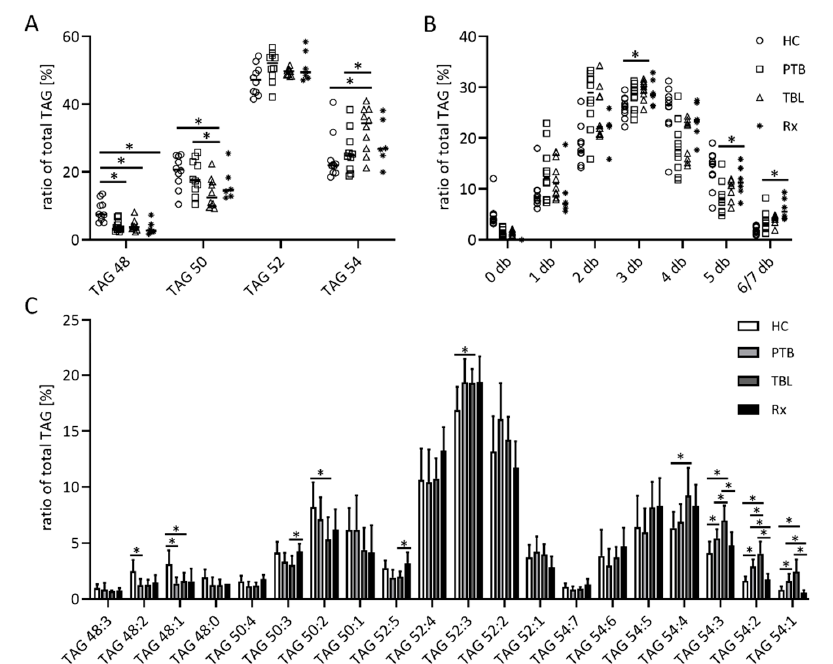
Figure 5. Composition of the triacylglycerol (TAG) fraction of exosomes from TB patients. Organic extracts of exosome-derived lipids isolated from patients with pulmonary tuberculosis (PTB) and tuberculous lymphadenitis (TBL) as well as PTB-treated patients (Rx) were separated by high-performance thin layer chromatography. TAG-containing spots were automatically eluted with methanol and directly analyzed by ESI-IT MS. The sum of TAG species with 48, 50, 52, and 54 C atoms ( A ), the sum of TAG species with a certain amount of double bonds (db) in their fatty acyl residues, ( B ) as well as the relative amounts of single TAG species ( C ), were calculated from the sum of the signal intensities of all TAG. Data sets in ( A ) and ( B ) are depicted as dot plots to show all single values, data sets in ( C ) are depicted as bar graphs showing the mean and the positive standard deviation. Statistical significance was determined using the unpaired t test and the Holm–Sidak method to correct for multiple comparisons (alpha = 0.05). * p < 0.05.